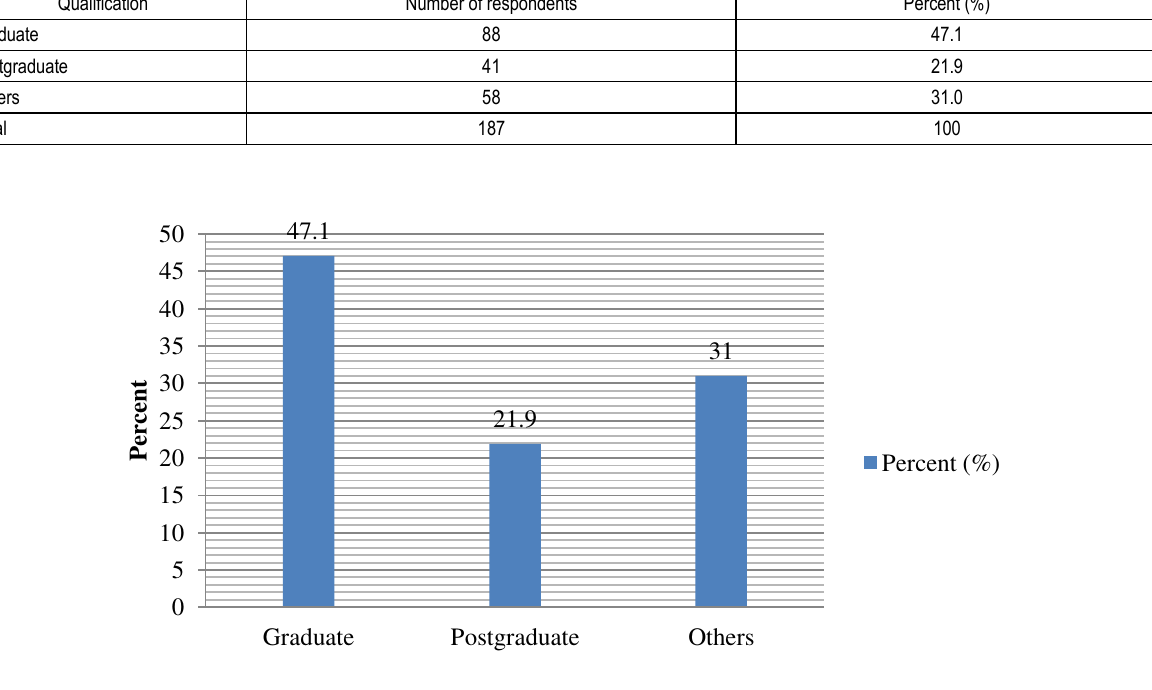
Fig. 2. Educational background or qualification percentage of research respondents